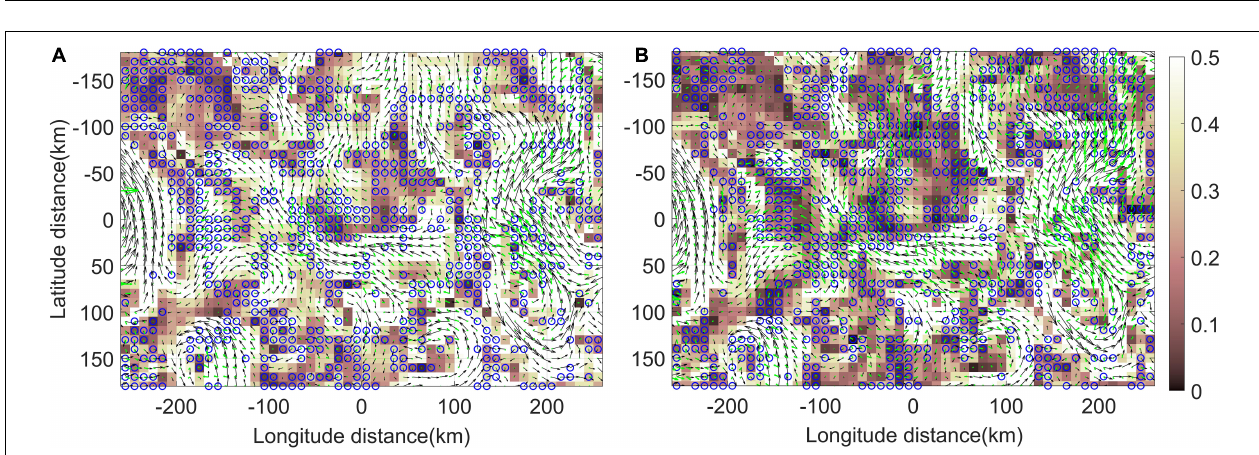
FIGURE 3 | Surface current reliability determination based on CNN evaluation for SST-R (A) and SST-G (B) . The black vector is the model surface current (true), and the green vector is the PIV surface current (calculated). The background color represents the difference (CMRI error) between the true value and the calculated value (0: lowest error / 1: highest error). The blue circles designate the vectors within top 30% having high reliability evaluated by deep learning CNN.